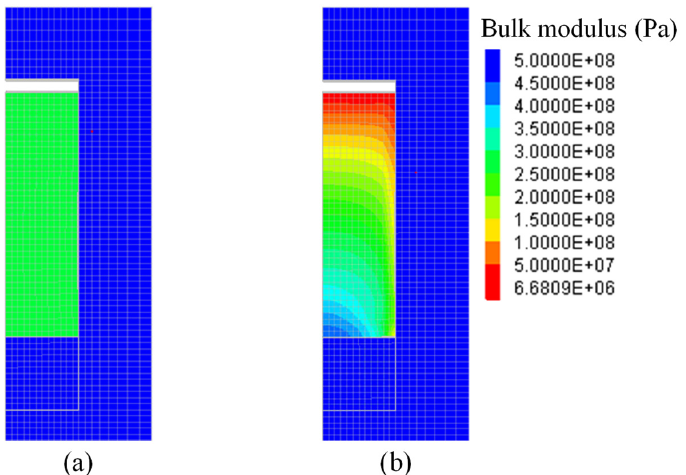
Figure 12. Distributions of the bulk modulus in overlying backfill after placement simulated with the ( a ) Mohr–Coulomb and ( b ) Soft Soil models.